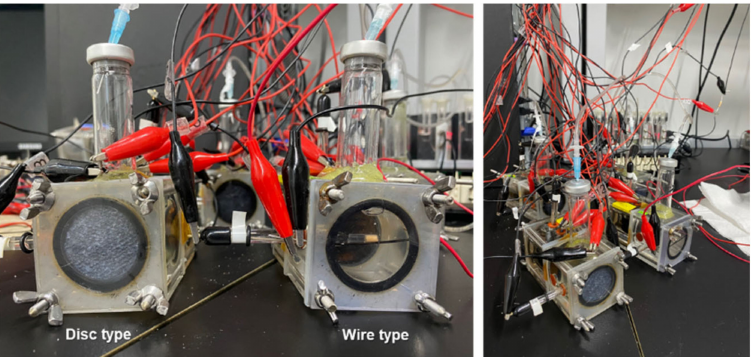
Figure 1. Images of two different cathodes and